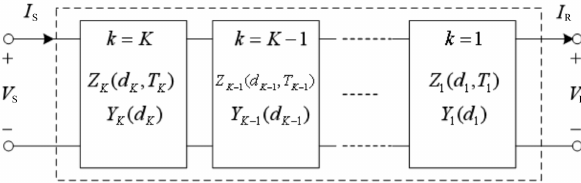
Figure 3. Multisegment transmission line